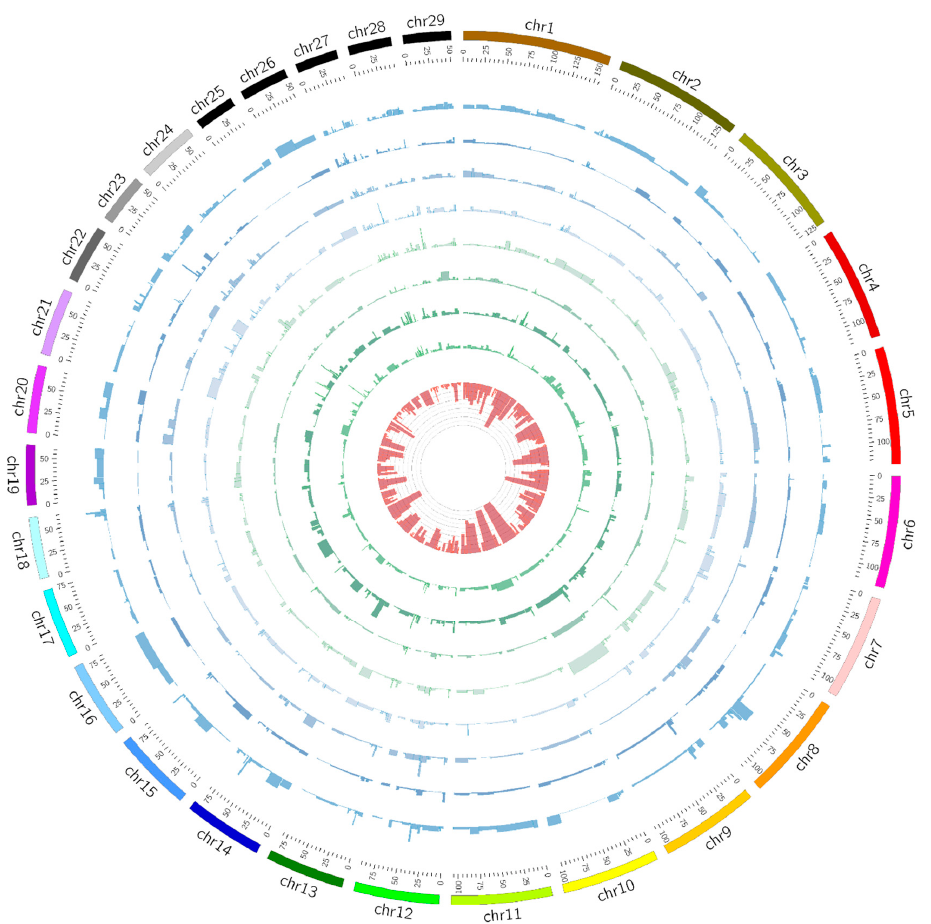
Figure 3. Circos plot illustrating ROH regions and association results for eight traits. Association significance test for each of ROH was plotted based on − log 10 ( p ) values using histograms within the gray inner circle. The ROH frequency was determined by occurrence of ROH with each region within the population. The estimated frequency values were shown in the innermost circle. The outermost circle displays the cattle autosomes. The circles from inside to outside represent association results for body height, body length, chest circumference, fat coverage, backfat thickness, ribeye area, carcass length, and slaughter weight,